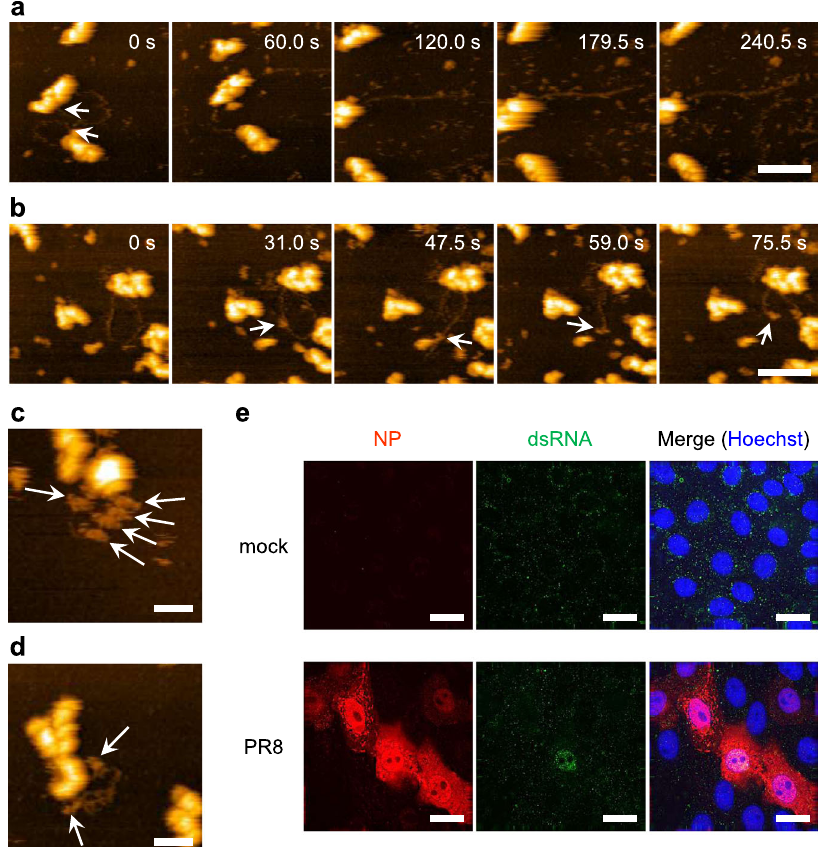
Fig. 4 Production of a double-stranded RNA by vRNP. a, b Digestion of looped RNAs with RNases. During HS-AFM observation of looped RNA associated with vRNP, RNase A ( a ) or RNase III ( b ) was added to the liquid chamber at a fi nal concentration of 0.5 μ g mL − 1 or 0.02 U μ L − 1 , respectively. Five images were arbitrarily selected from each movie at the indicated times. One end of the looped RNA was detached from vRNP by adding RNase A at the position indicated by arrows ( a ). By contrast, RNase III digested looped RNA where the RNase bound ( b , arrows). Scale bars represent 100 nm. c, d Binding of anti- dsRNA antibodies to RNA associated with the vRNP. Antibodies bound to looped RNA ( c ) and to folded RNA ( d ) are indicated by arrows. Results were reproduced at least fi ve times. Scale bars in c, d represent 50 nm. e Detection of dsRNA in virus-infected cells by IFA. Vero cells were infected with in fl uenza virus PR8 strain at MOI of 1. Infected cells were fi xed at 10 h post-infection and double-stained with anti-NP and anti-dsRNA antibodies. Cell nuclei were stained with Hoechst. Scale bars, 20 μ